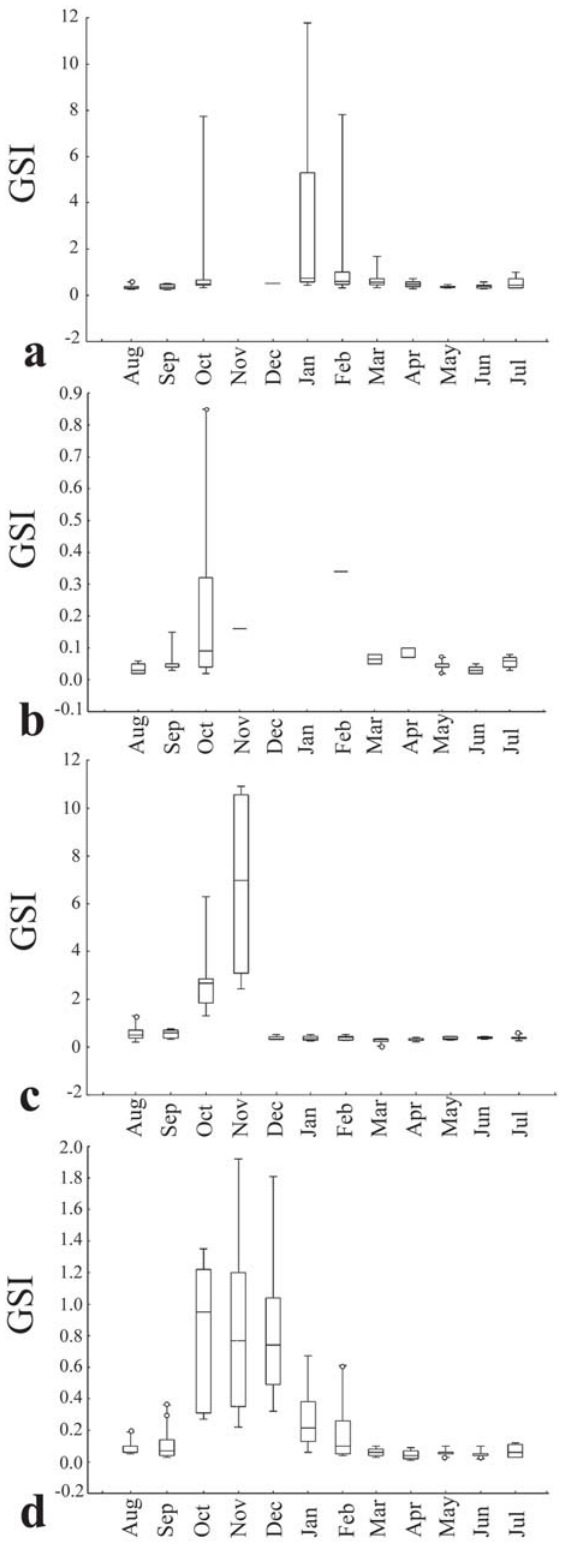
Fig. 4. Monthly variation of the gonadosomatic index (GSI) of P . mesopotamicus females and males in the headwaters (a,b) and the flood area (c,d), respectively, between August 2006 and July